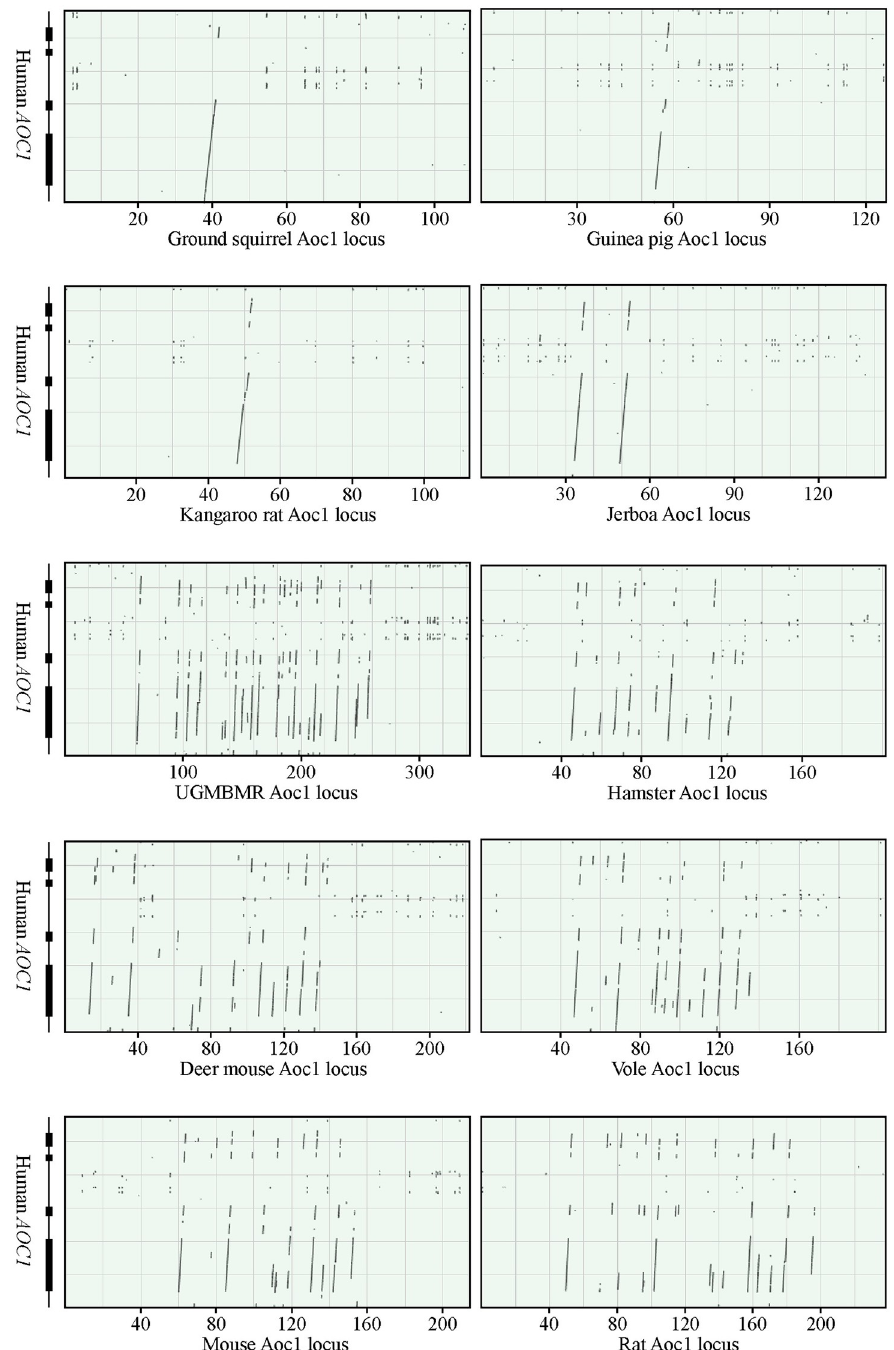
Fig 12. Duplication of Aoc1 in myomorph rodents. The Aoc1 locus in rodents were analyzed with BLAST in order to detect DNA sequences with homology to the human AOC1 . The result is displayed in dotplots, with illustrations of the human AOC1 shown to the right. The Aoc1 is duplicated in all myomorph species, whereas there are no duplication in the non-myomorph species ground squirrel, guinea pig, and kangaroo rat.